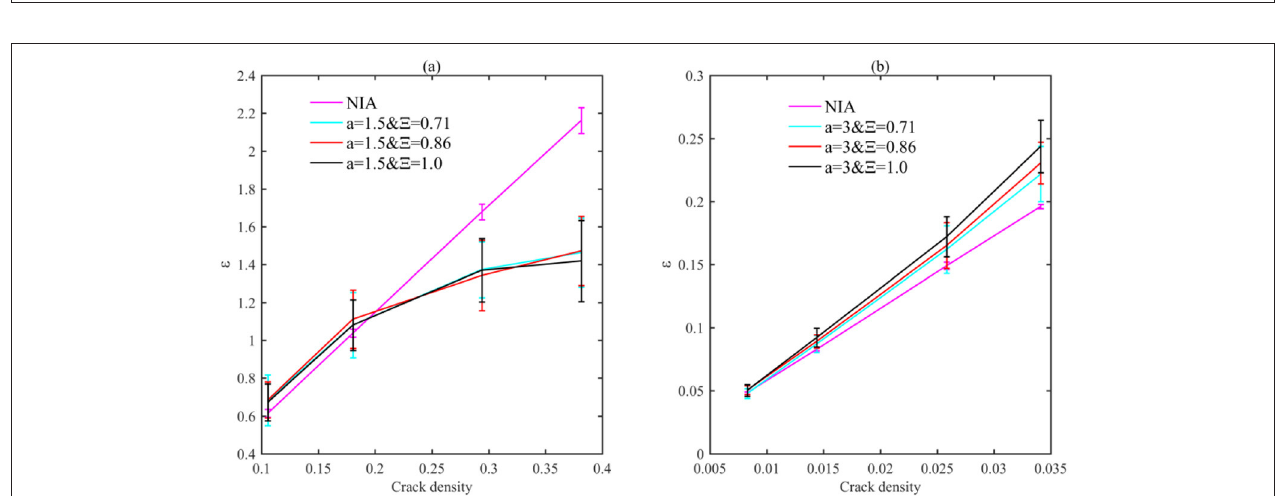
FIGURE 7 | C 44 as the functions of fracture densities for different models determined by a and 4 , using the NIA solution and the numerical method. The numerical result bars are in line with those in Figures 5 , 6 .